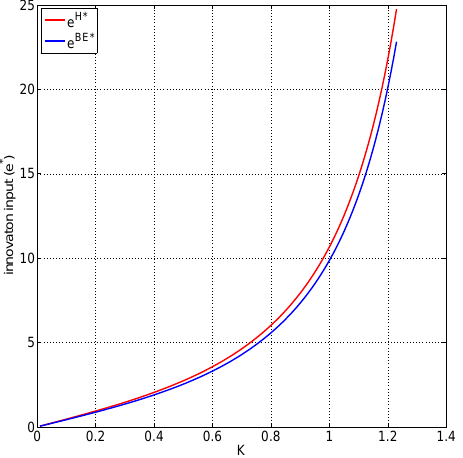
Figure 7. The influences of K on the innovation input e